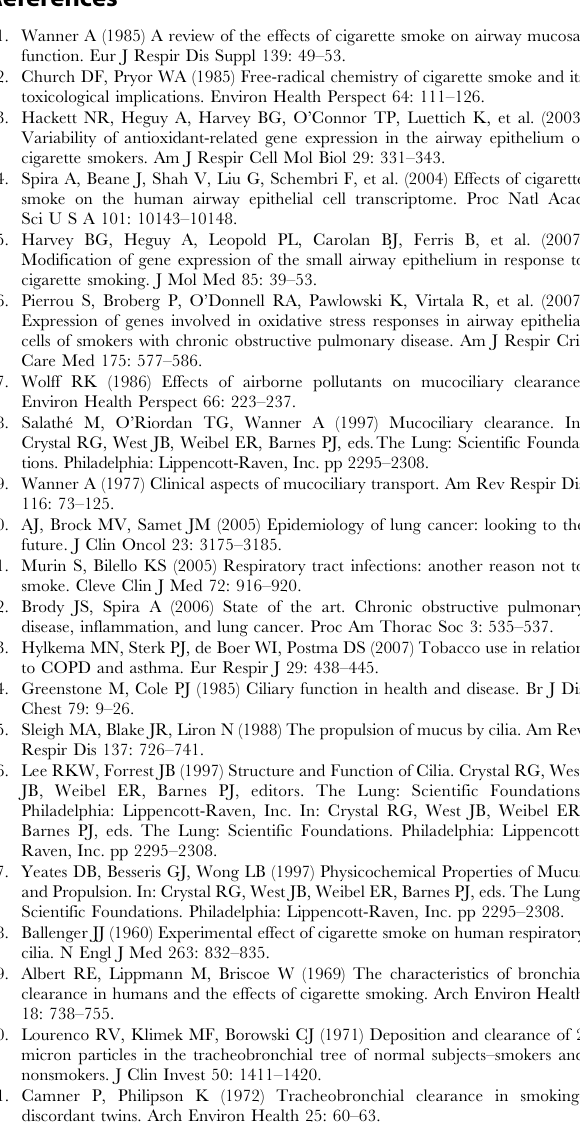
Figure S3 Plot of cilia length distributions for each individual in the hydrated, unfixed cell study. To better understand the variability of cilia length from cell-to-cell within an individual, the distribution of cilia lengths within each individual in the hydrated cell study were plotted (data correspond to Figure 4). Raw cilia length data were collected in 0.5 m m bins (x-axis) and the % of the population in each bin was plotted on the y-axis. Graphs have been displaced on the y-axis to clarify the individual distributions. The theoretical length of cilia needed to extend through the airway epithelial lining fluid is shaded in gray. Of interest, in 4 out of 10 smokers, . 25% of individual cells were observed to have cilia lengths that fell below the theoretical length needed to contribute to mucus movement. These data, as well as the data in Figure S1, suggest that individual smokers may exhibit a greater risk for shortened cilia.